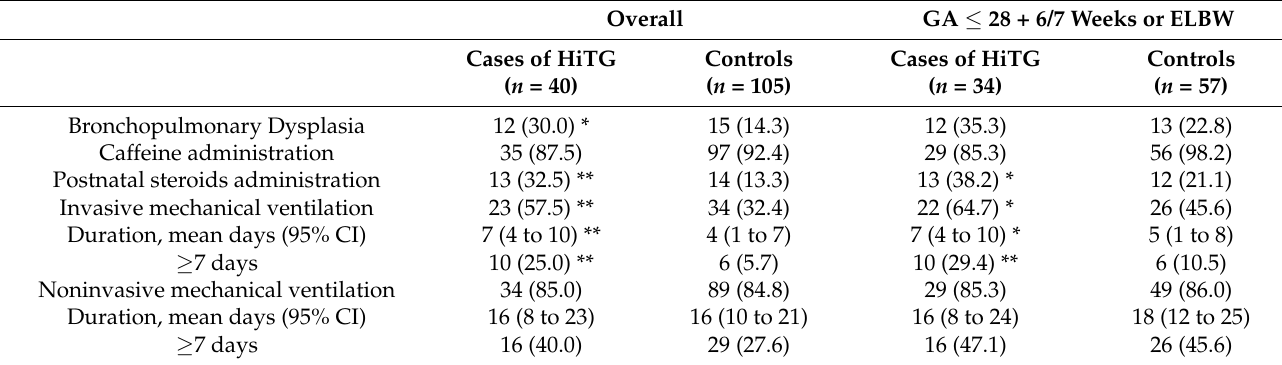
Table 2. Respiratory outcome of neonates with hypertriglyceridemia compared with controls.